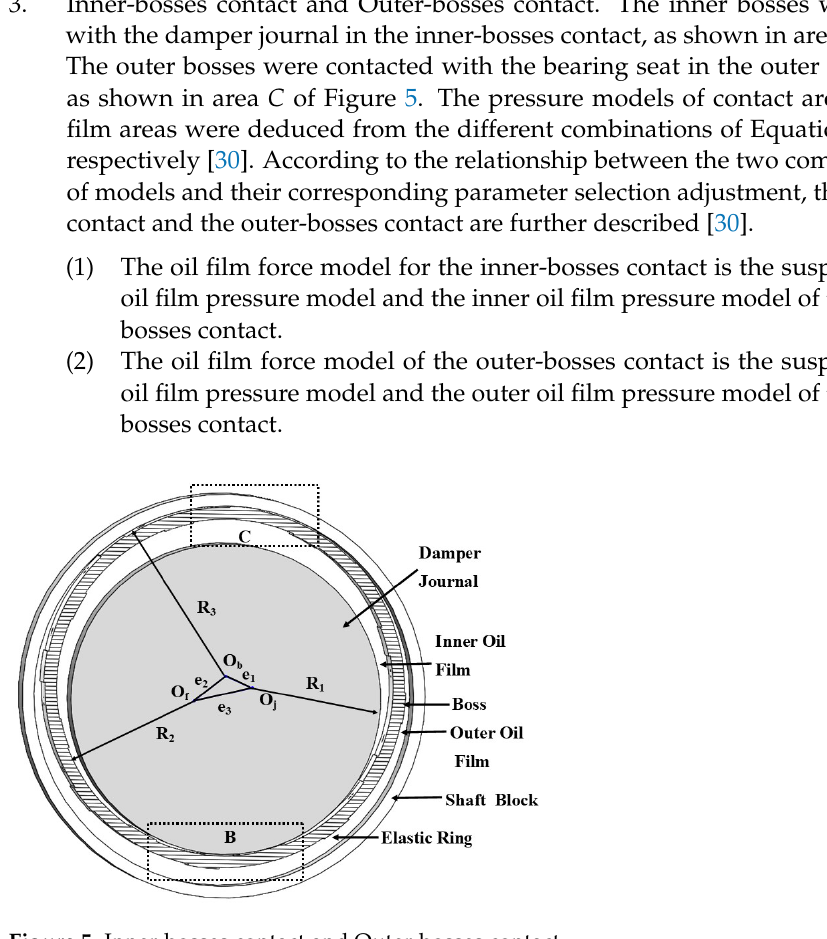
Figure 5. Inner-bosses contact and Outer-bosses contact. Furthermore, it was compared with the typical squeeze film dampers of SFD, PSFD, and FRSFD. The transient pressure model of the oil film of the squeeze film damper (SFD) with oil